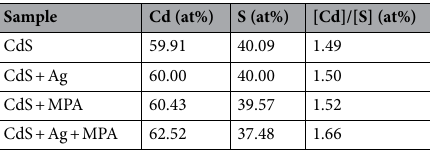
Table 3. Elemental compositions at different molar ratio (Atomic